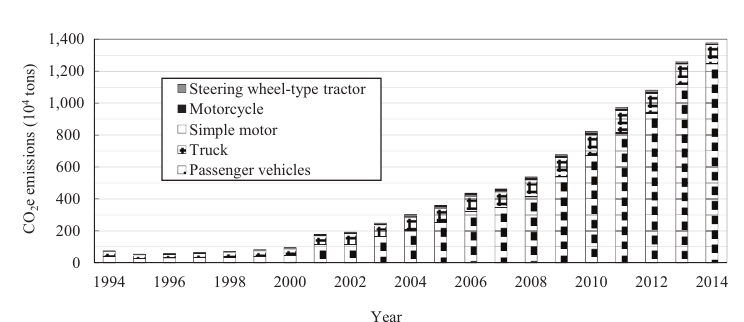
Figure 4. Accumulated CEs of different traf fi c